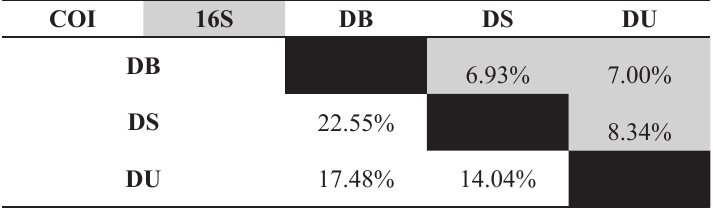
for 16S (Table 3). The overall mean distances within Sechelleptus (calculated as the estimates of average evolutionary divergence over all sequence pairs) is 14.9% for COI and 5.1% for 16S (Tables 2–3).